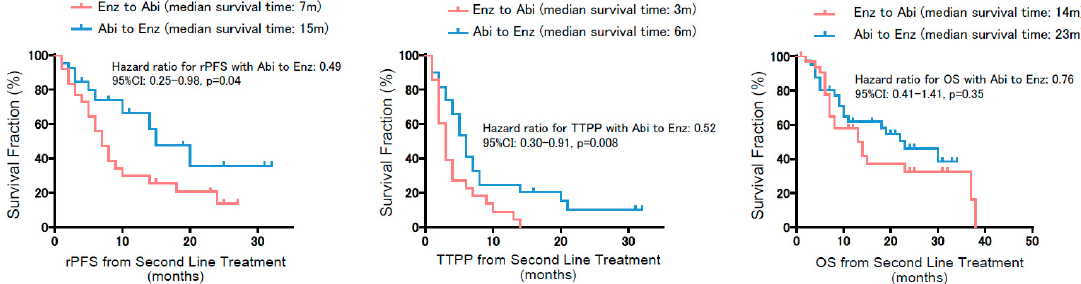
Figure 4. Kaplan–Meier curves for radiographic progression-free survival (rPFS), time to PSA progression (TTPP), and overall survival (OS) from the initiation of the second-line treatment. Note that rPFS and TTPP from the initiation of the second line significantly favored enzalutamide following abiraterone compared to vice versa.